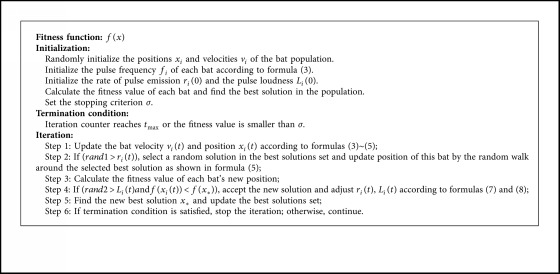
 Bat Algorithm (BA).